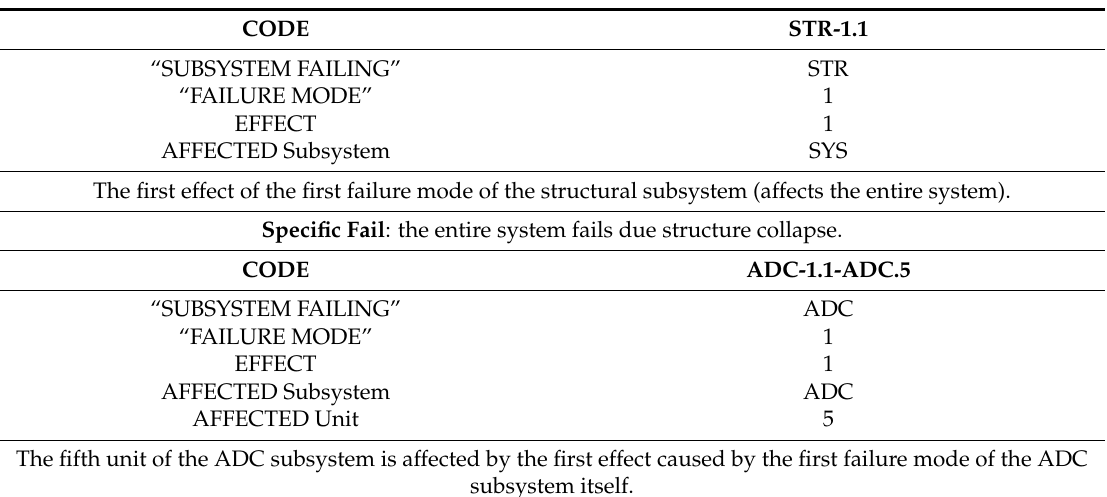
Table 13. Traceability of Failures in FMECA